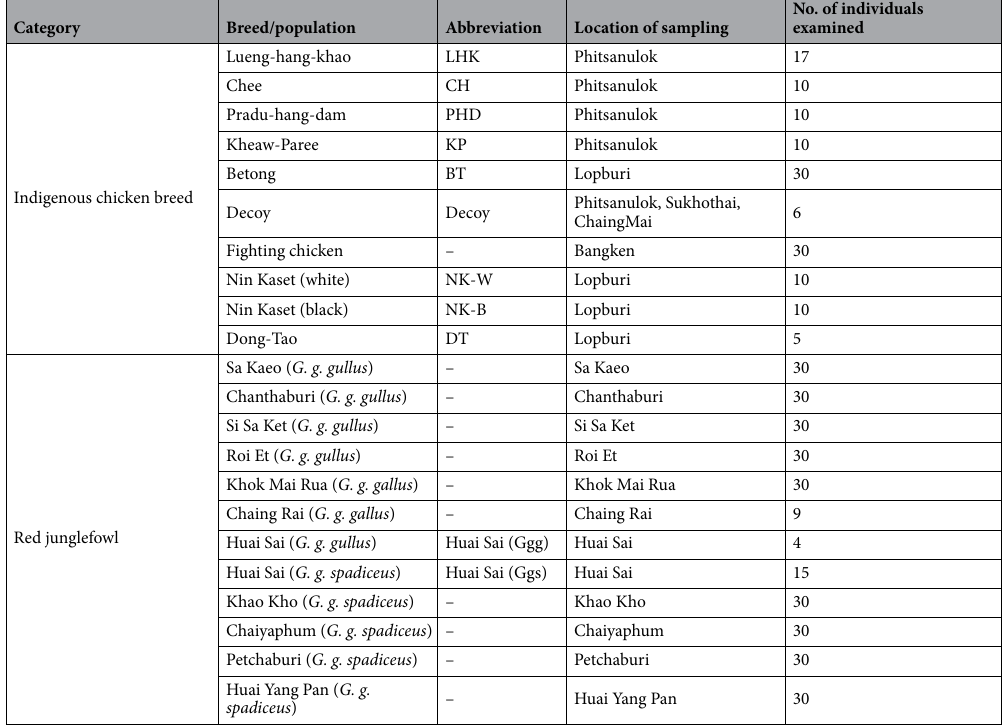
Table S2): Hap_04 (BT); Hap_07 and 08 (NK-W); Hap_09 (NK-B); Hap_10 and Hap_11 (LHK); Hap_14 (CH); Hap_17 (PHD); Hap_18 to 20 (Decoy); Hap_29 to 33 (fighting chicken); Hap_21 (Huai Sai [Ggg]); Hap_22 (Huai Sai [Ggs]); Hap_24 and 25 (Sa Kaeo); Hap_27 and 28 (Chanthaburi); Hap_36 (Khao Kho); Hap_38 and 39 (Chaiyaphum); and Hap_43 and 44 (Khok Mai Rua). Twenty-nine out of 44 D-loop haplotypes which had not been previously deposited in GenBank, were newly identified in the present study. The topologies of the Bayesian tree and the maximum-likelihood (ML) tree based on the HKY + G + I model of evolution, which were selected as the best-fit substitution model, were fundamentally similar. Although the Bayesian posterior probability of the internal nodes and the ML bootstrap values were relatively low due to the short internal branches (multifurcations) of the phylogenetic trees, the haplogroups A, B, F–I, K, Y, and Z were supported by a Bayesian posterior probability of greater than 0.97 (Supplementary Figs. S1, S2). Both The trees